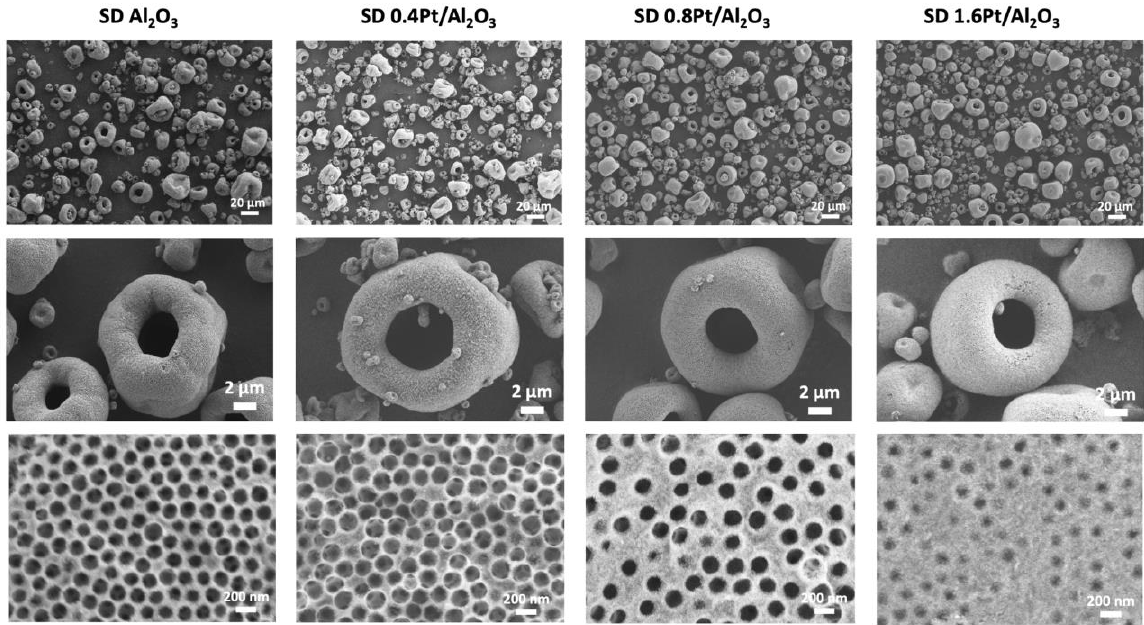
Figure 3. Representative SEM images of porous SD microparticles synthesized using Pt@PS colloids with different loadings of Pt. The weight percent of Pt increases from left to right (0% for the left column, up to 1.6 wt% for the right one, as determined through post-synthesis ICP-MS analysis, and indicated in the column header). The magnification of the SEM images increases from top to bottom. Samples were prepared using 200 nm PS particles and a slurry concentration of 10 wt.%.